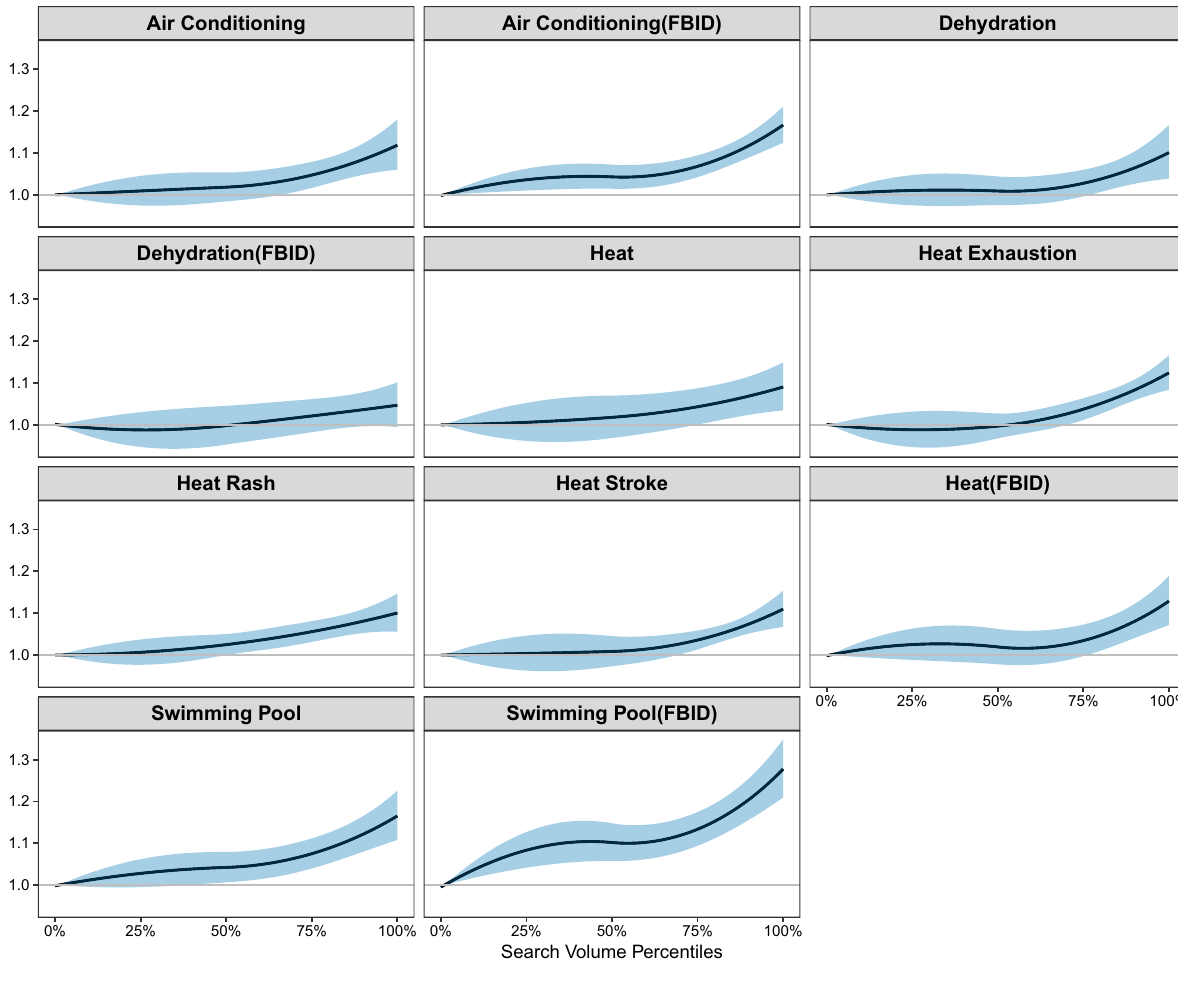
Figure 7. Cumulative exposure–response curve for the relative risk of heat-related ED visits for percentiles of DMA-specific search terms over lags 0–5 days. Reference search volume: 1st percentile of DMA-specific search volume distribution.